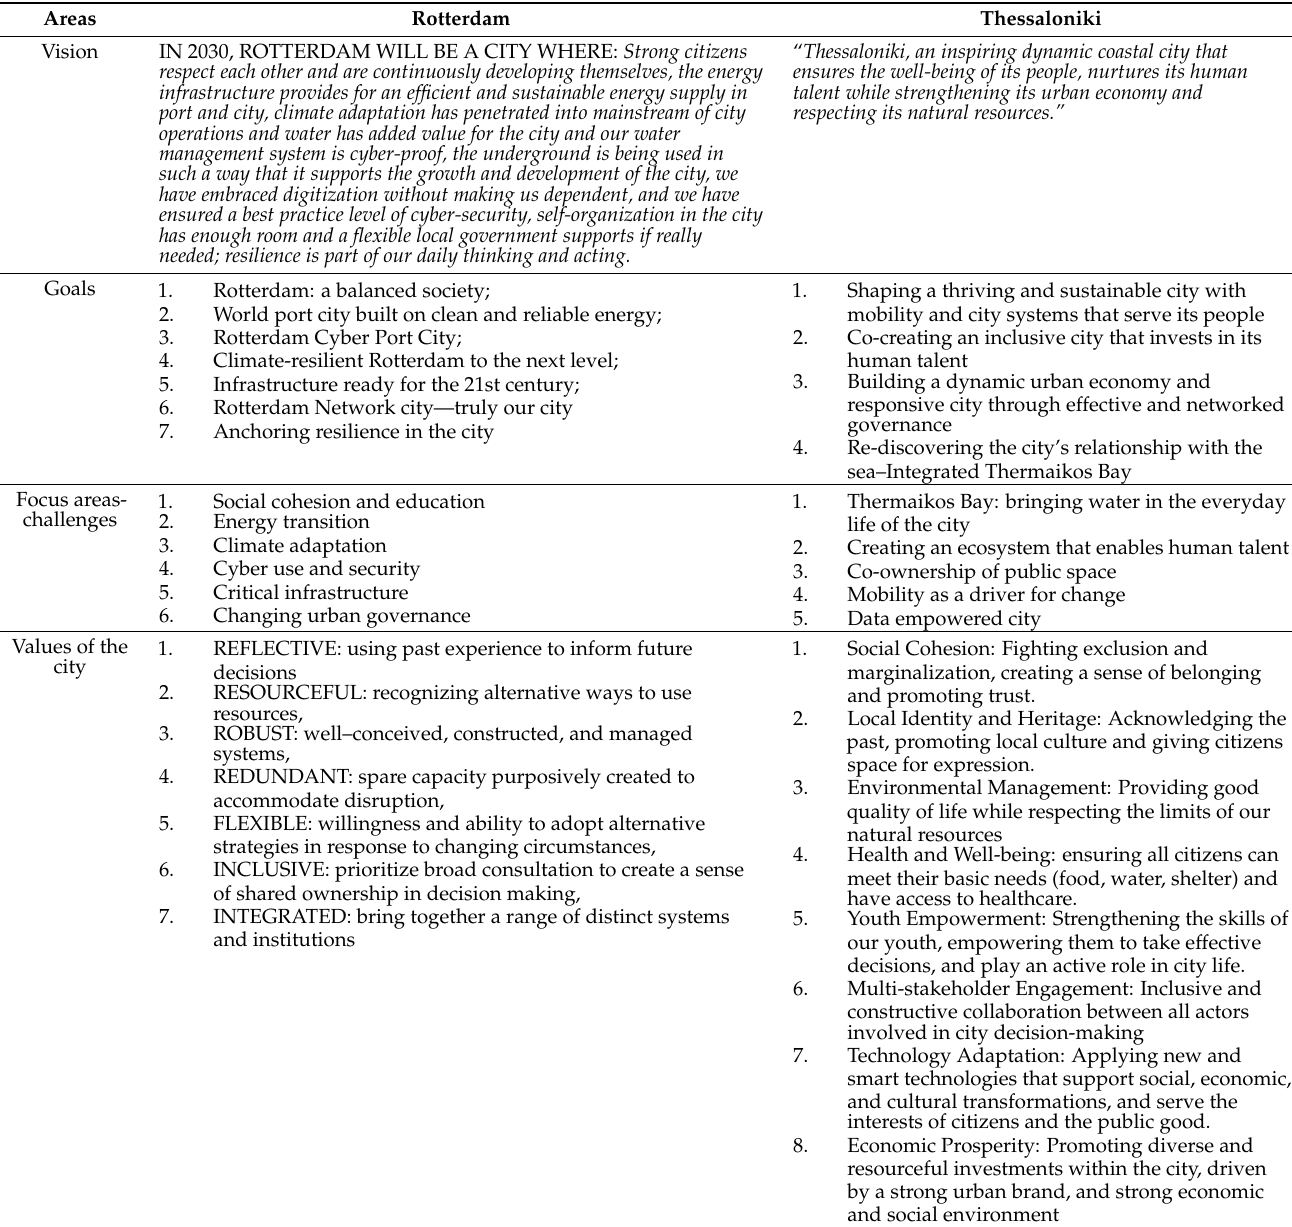
Table 1. Content analysis on resilient strategies of Rotterdam [59] and Thessaloniki [60].